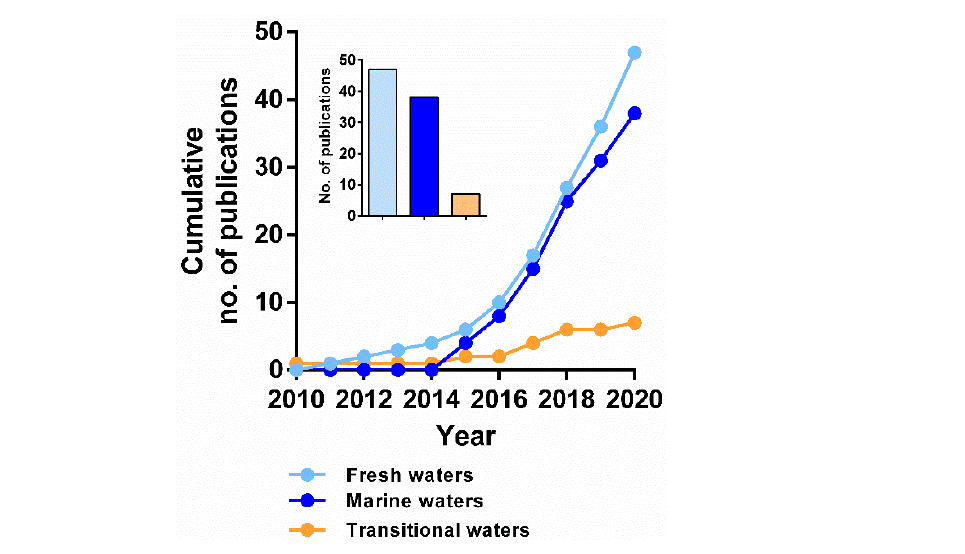
Figure 1. The cumulative number of articles published over the last decade meeting the criteria that assessed benthic macroinvertebrate taxa using (e)DNA metabarcoding on each type of aquatic ecosystems.